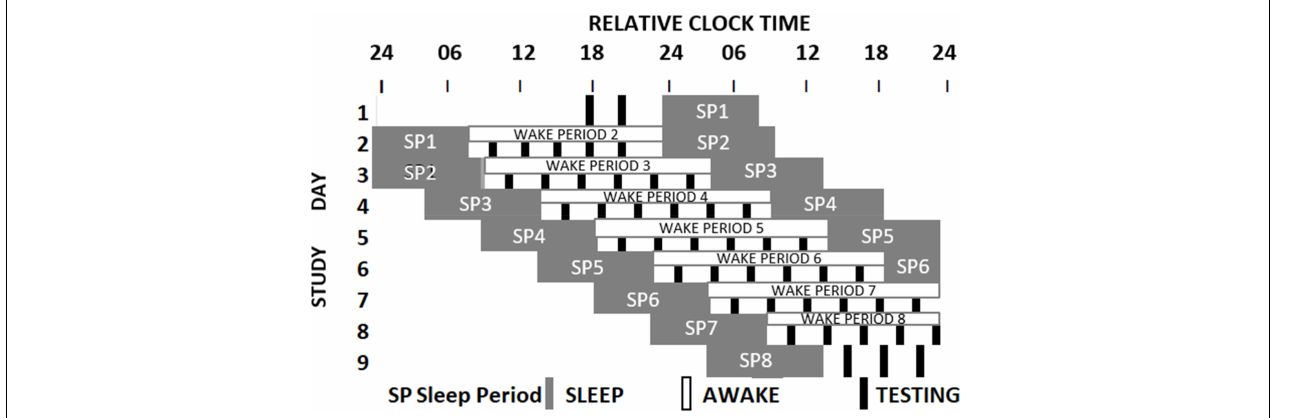
FIGURE 2 | Schematic representation of the Forced Desynchrony protocol. After two baseline days participants were scheduled to a 28-h sleep wake cycle by extending the sleep opportunity to 9h:20 min and the wake period to 18h:40 min. Light intensity was low during wake periods. During each wake period 6 assessments of cognition and mood (black boxes) were conducted. The melatonin rhythm (not shown) cannot follow the 28-h sleep-wake cycle and oscillates at it near 24-h intrinsic period. As a consequence, mood assessments occur at different circadian times (Santhi et al., 2016).